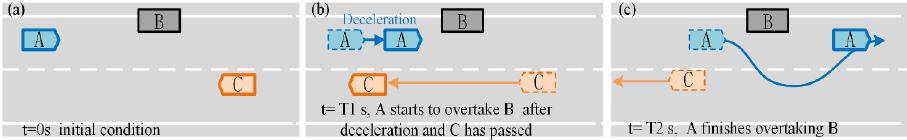
Figure 3. The case of ego vehicle slowing down. ( a ) Relative positions between vehicles at t = 0 s; ( b ) Relative positions between vehicles at t = T1 s; ( c ) Relative positions between vehicles at t = T2 s.